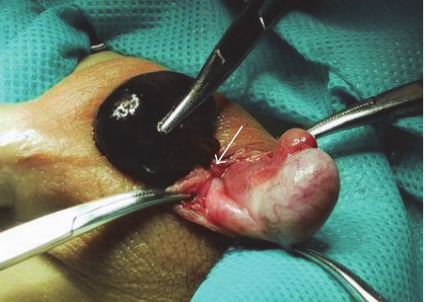
Figure 1: Enlargement of left hemiscrotum and a painful, palpable cystic mass.